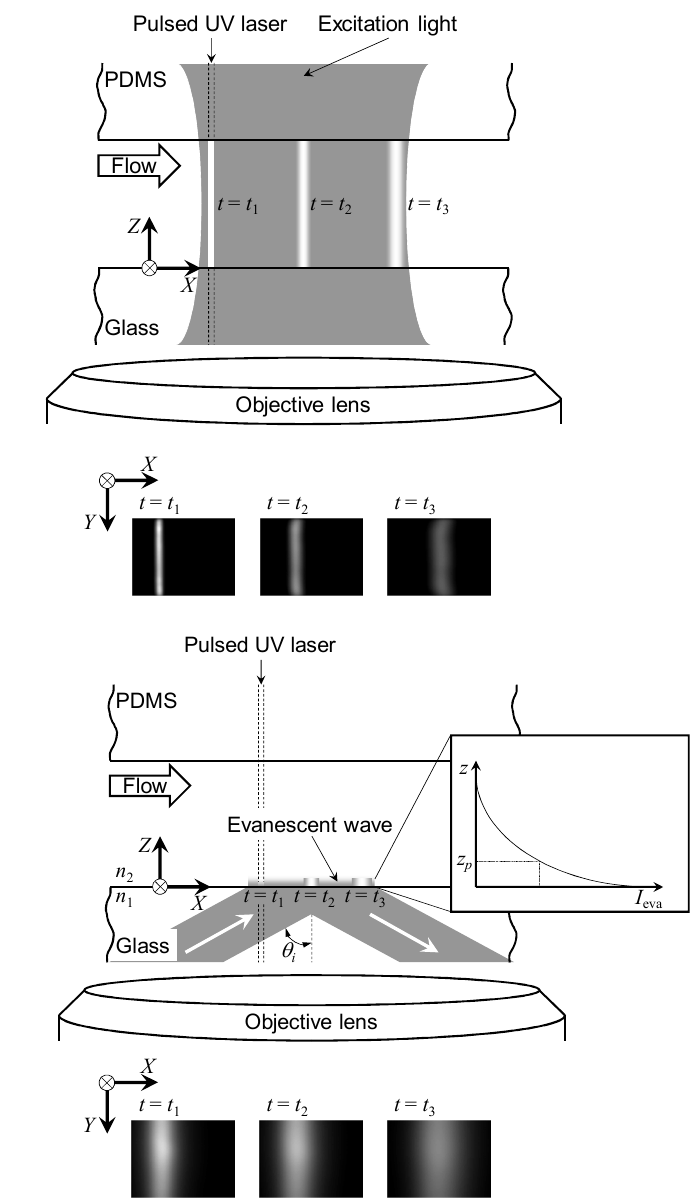
Figure 1. Schematic concept of ( a ) molecular tagging (MT) by volume illumination and ( b ) evanescent wave molecular tagging